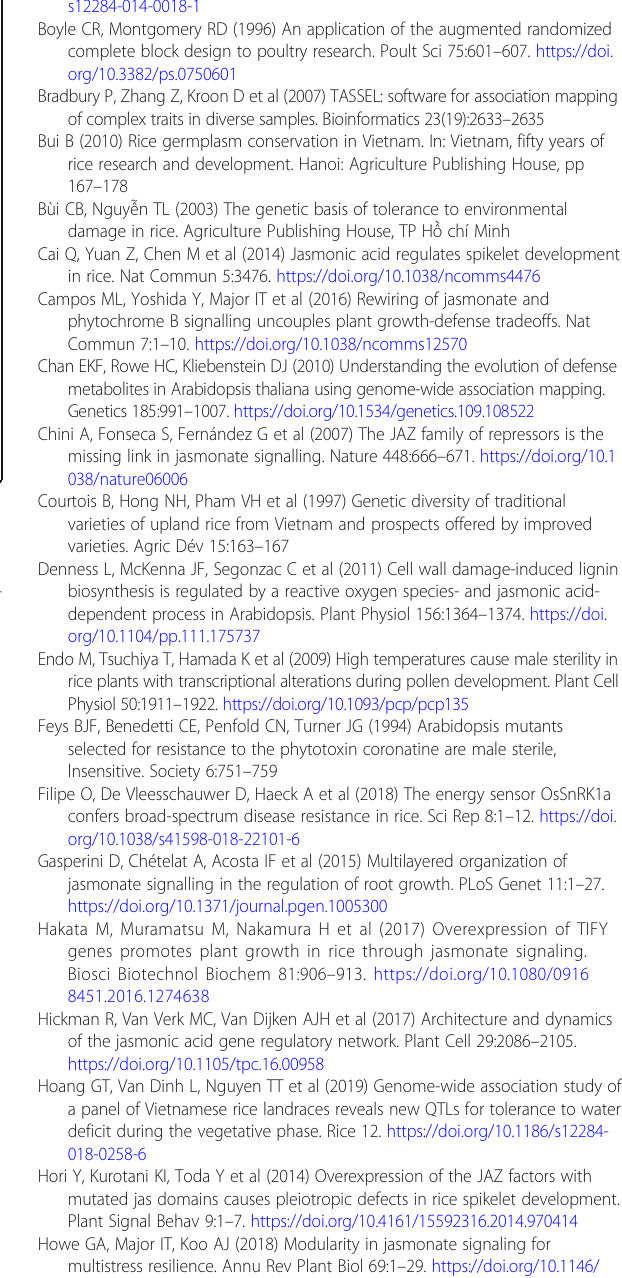
Additional file 6: Figure S7. Haplotype analysis for qTTW5. (A) Linkage Disequilibrium heatmap in the peak region of association analysis